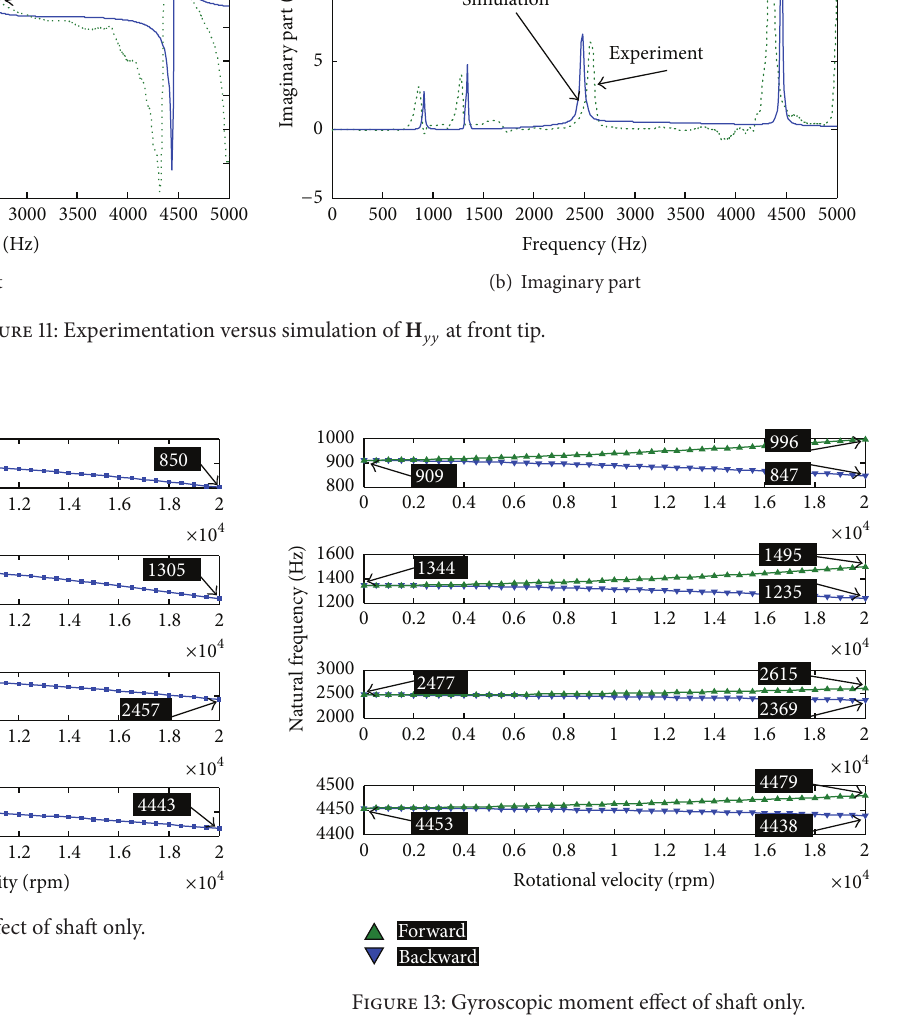
As the damping matrix [ 𝐶 ] consists in gyroscopic ], and disk ele- moment matrices of beam elements, [ 𝐺 bm ] , in (13), the forward and backward modes of ments, [𝐺 disk shaft should be reflected in the FRF. Direct FRF H 𝑦𝑦 at the front tip is calculated based on the validated FE model in 3.2, and the rotating speed is set as 10000 rpm. Three direct FRFs are presented in Figure 15, where the structural damping , are set as 0.5%, 2%, and 5%, respectively. It ratios, 𝜉 system is clearly seen that there are two peaks at every normal mode due to the forward mode and the backward mode when the structural damping ration is 0.5%. If the structural damping ratio increases to 2%, magnitudes of two peaks of every normal mode diminish and peaks become closer. If the structural damping reaches 5%, however, the two peaks of each mode can hardly be observed. The simulation